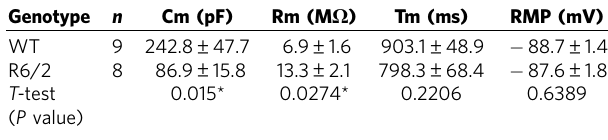
Table 2 | Membrane properties of astrocytes recorded from WT ( B6CBAF1/J , n ¼ 9) and R6/2 ( n ¼ 8) mice.